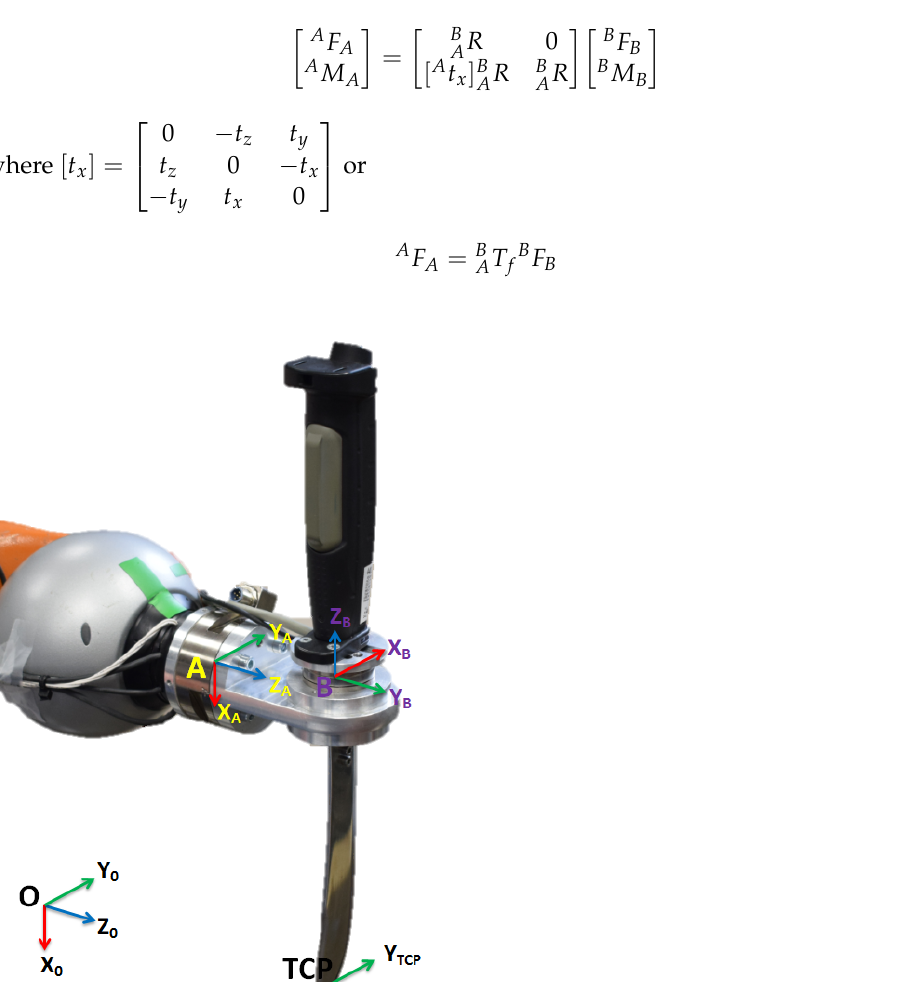
Figure 9. Attaching the FT sensor A to the KUKA LWR 4+ robot end-effector. The relation between the different frames associated to these sensors (A and B), to the tool (i.e., tool center point—TCP—or tip of the knife) and the robot world frame O are shown in Table 3 and visualized in Figure 10. To use the impedance controller all the forces must be in the same frame. This requires transformation of the sensed forces in the sensor frame to the end-effector frame of the robot. The equation for transformation of forces from one frame to another is: